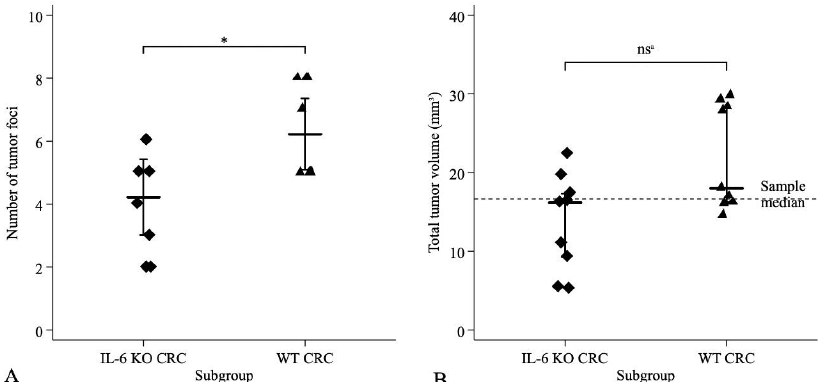
Figure 1. Distribution of ( A ) tumor foci and ( B ) total tumor volume (TTV) in IL-6 KO CRC model and WT CRC model groups. Total number in both groups was n = 9. A—number of tumor foci with two-sided Student–test; B—TTV with nonparametric tests. * Two-Sided Student’s t -test: t 16 = − 2.79, p = 0.013. ns a ( a not significant) Kolmogorov-Smirnov test exact p = 0.352, Mann-Whitney test p = 0.058, non-parametric equality of medians test exact p = 0.347.